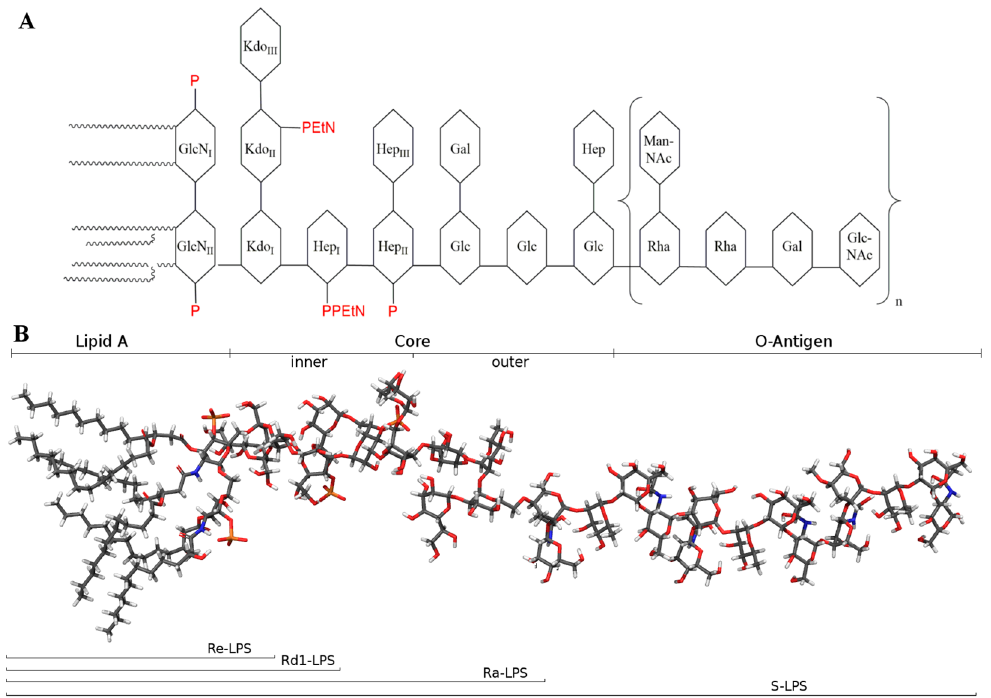
Figure 1. E. coli lipopolysaccharide (LPS): smooth-lipopolysaccharide (S-LPS) is composed by lipid A, core and O-antigens; truncated rough-LPS (R-LPS) are named Ra, Rd1, and Re depending on the number of sugar units of the core. ( A ) Schematic representation ( B ) Chemical